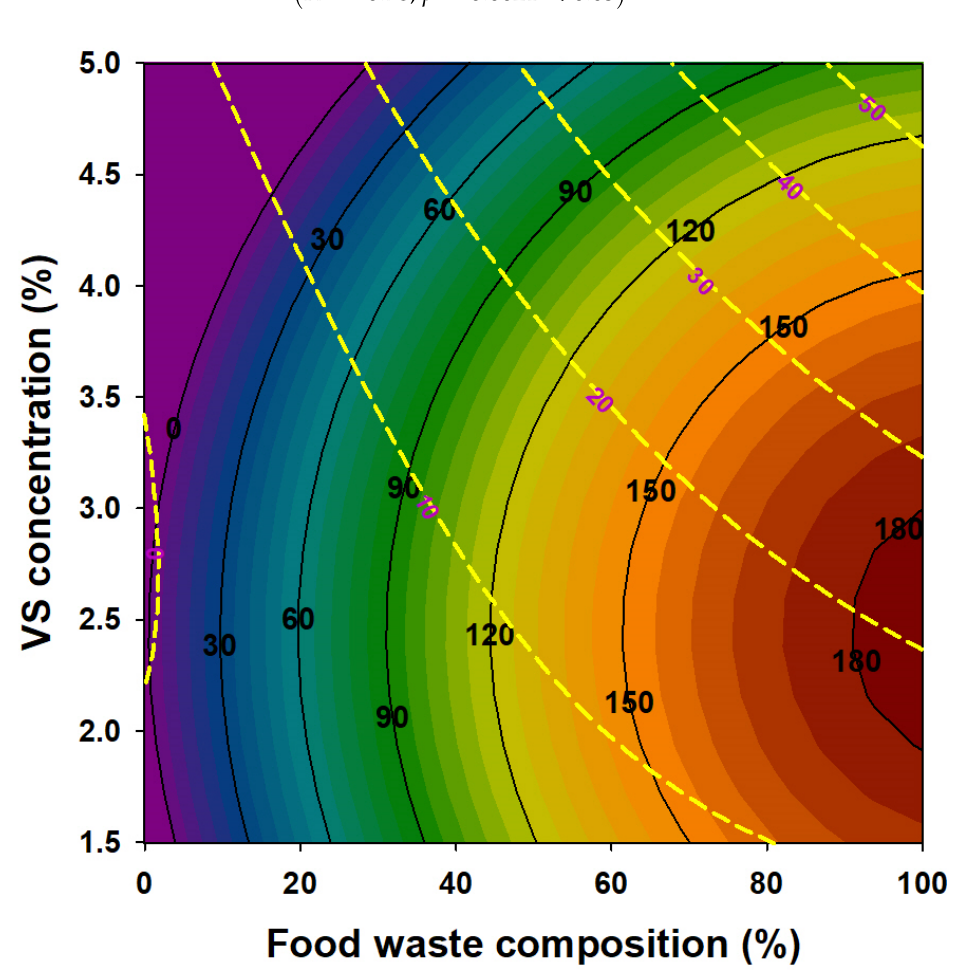
Figure 6. Contour lines of hydrogen production based on food waste carbohydrate added (mL H 2 /g food waste carbohydrate added ) against food waste composition and volatile solid (VS) concentration (solid line); contour lines of carbohydrate added concentration (COD basis) against food waste composition and VS concentration (g carbohydrate-COD/L) (dashed line).